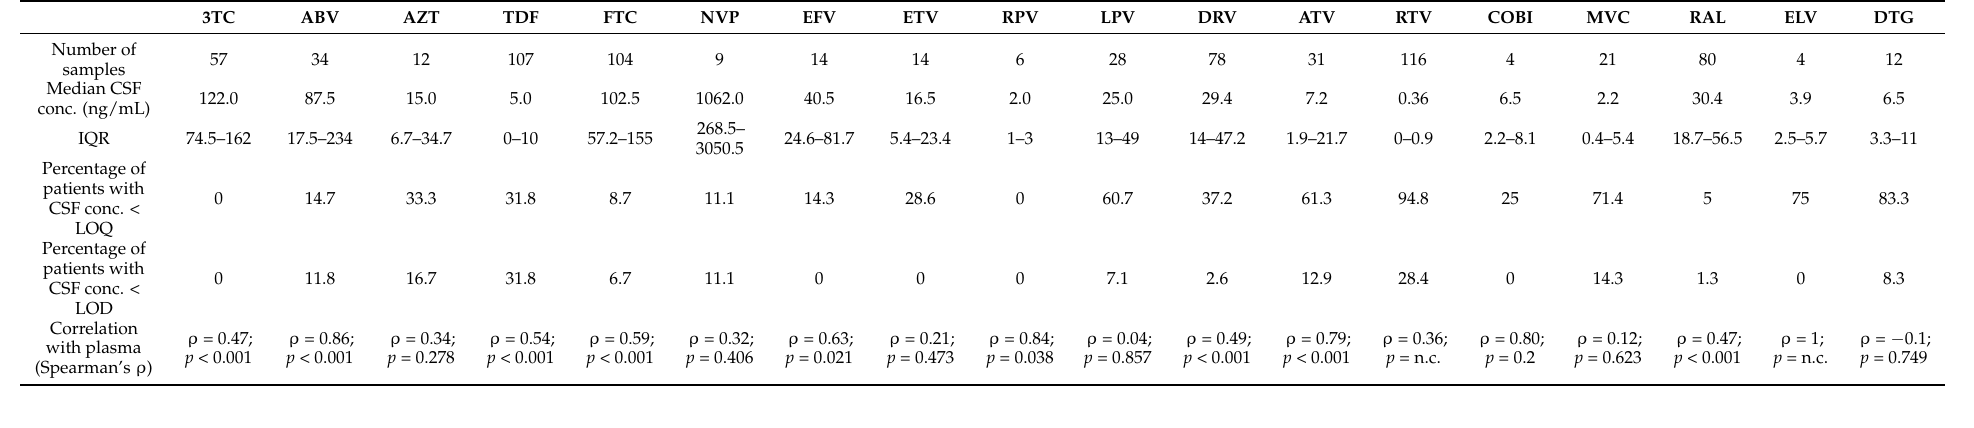
Table 1. Median CSF drugs’ concentrations and percentages of patients with concentrations above the instrumental limit of quantification (LOQ) and/or limit of